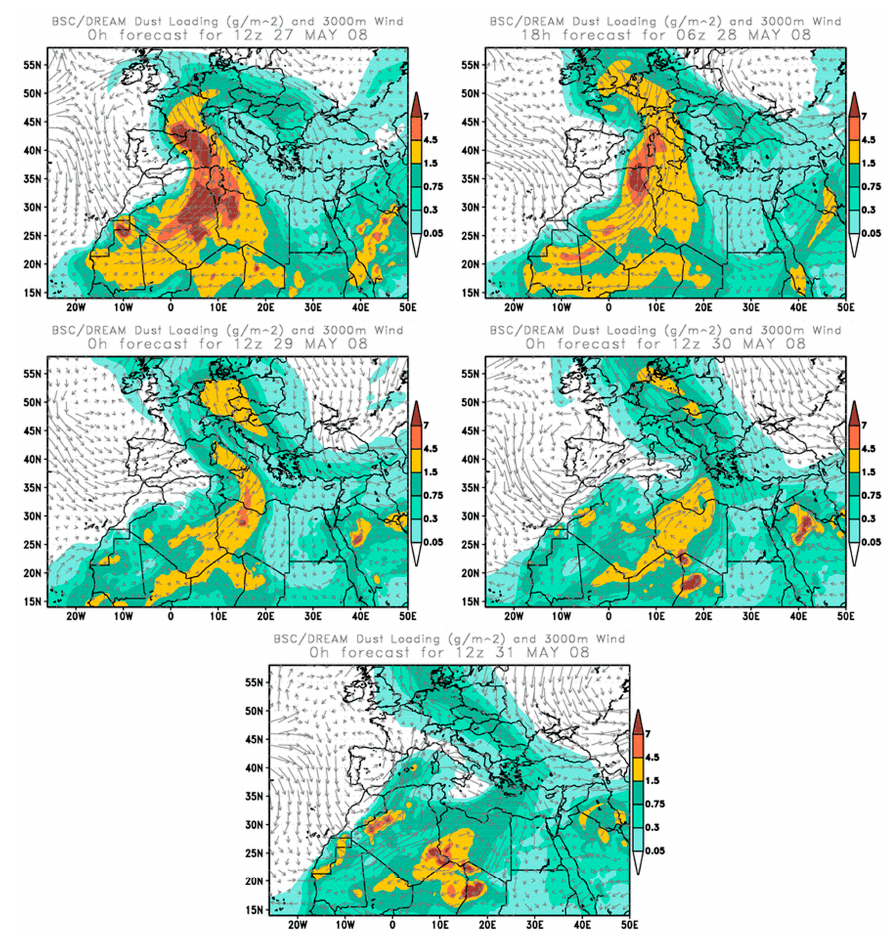
Figure 8. Example of the BSC-DREAM8b forecast products generated for the period 27–31 May 2008.